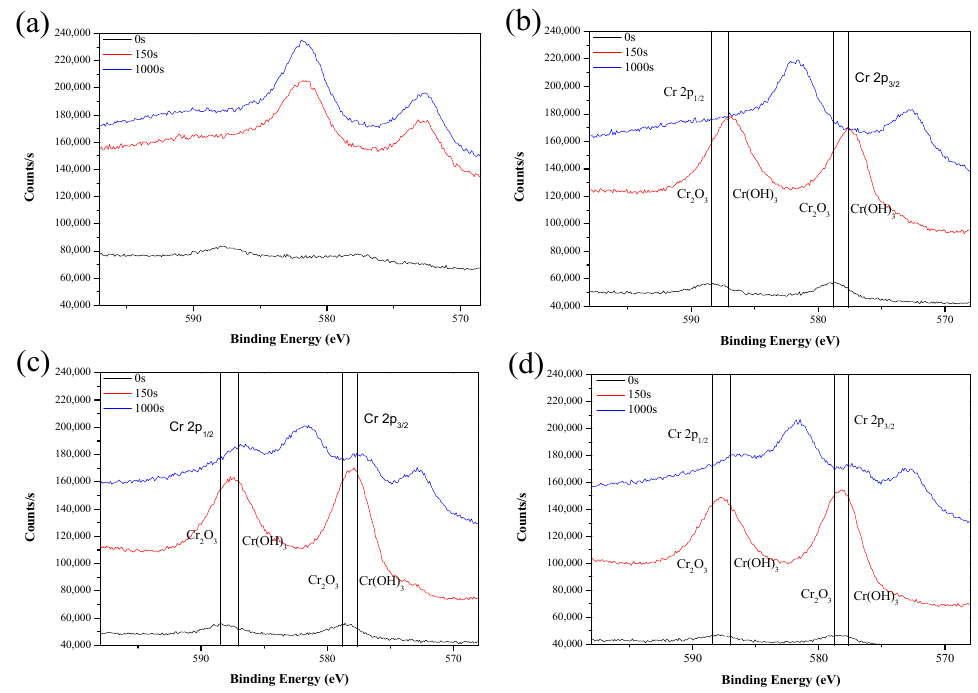
Figure 16. XPS spectra: Cr 2p binding energies determined from Cr 2p scans of ( a ) Zn–Ni alloy, ( b ) NaF 0% 60 s chromium conversion treatment, ( c ) NaF 50% 60 s chromium conversion treatment, and ( d ) NaF 100% 60 s chromium conversion treatment.